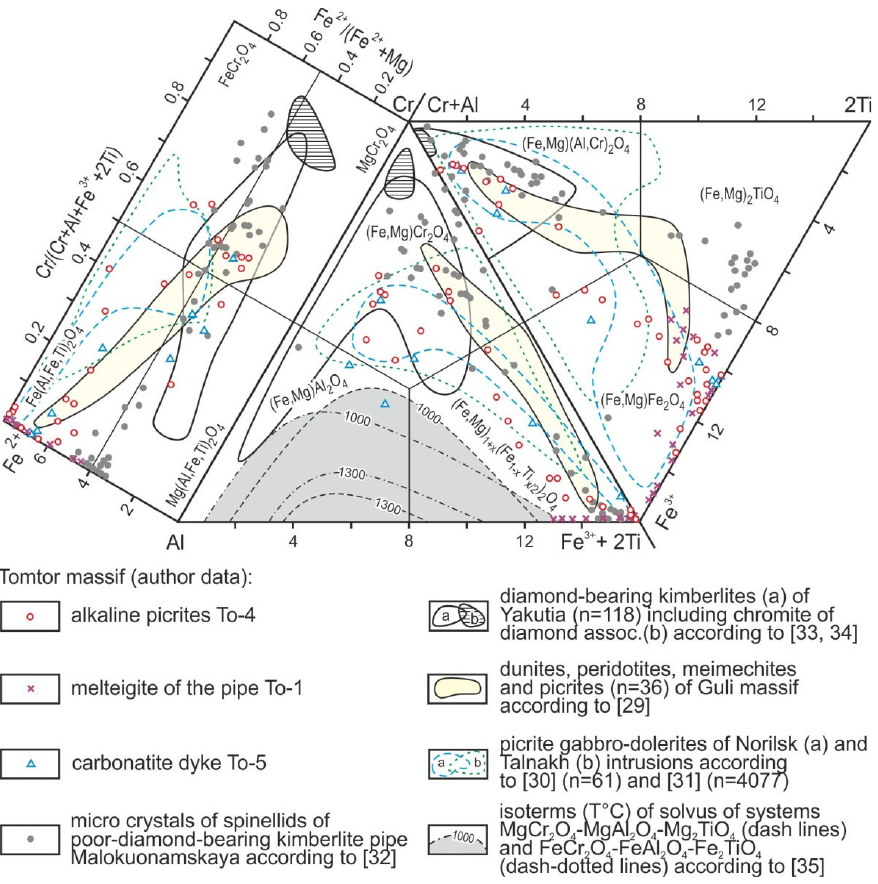
Figure 7. Composition of spinellids (n—number of analyses) from rocks north of Siberian platform [29,31–35]